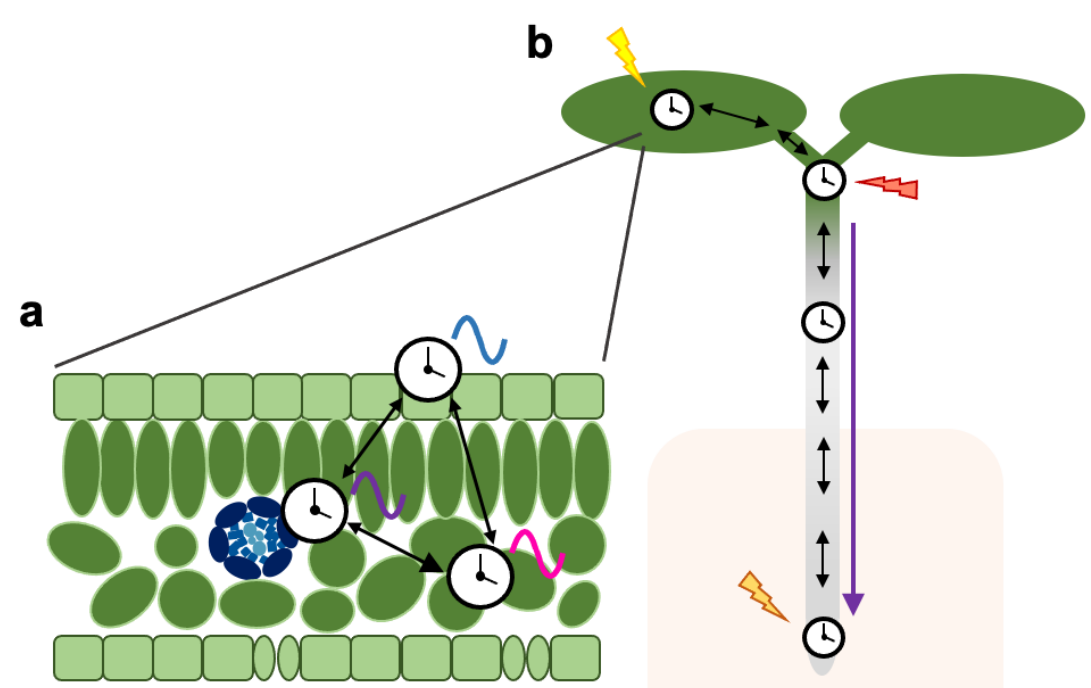
Figure 2. Schematic representation of spatial features of the plant circadian system. Black arrows indicate intercellular/inter- tissue communication. The purple arrow indicates long-distance communication. ( a ) Clocks in different tissues such as the vasculature, the mesophyll or the epidermis have distinct circadian characteristics and regulate different outputs (represented by colored waves), but are coordinated through local coupling mechanisms. In some instances, asymmetric relationships exist where the rhythmicity in one tissue strongly affects rhythms in neighboring cells. ( b ) Local clocks generate distinct rhythms partly due to their differential sensitivity to input signals (represented by colored lightning symbols). Heterogenous rhythms across the plant are coordinated through both intercellular coupling and long-distance com- munication.